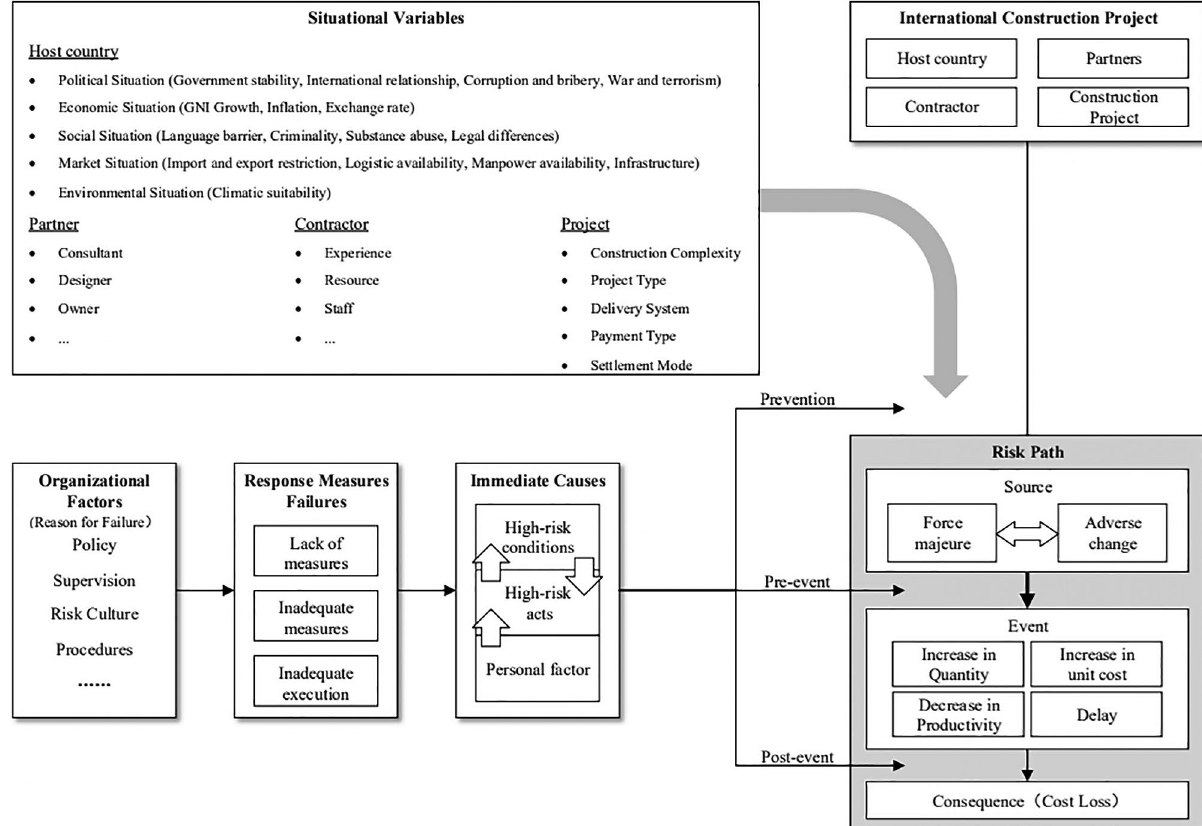
Figure 1. Risk causation model for international construction